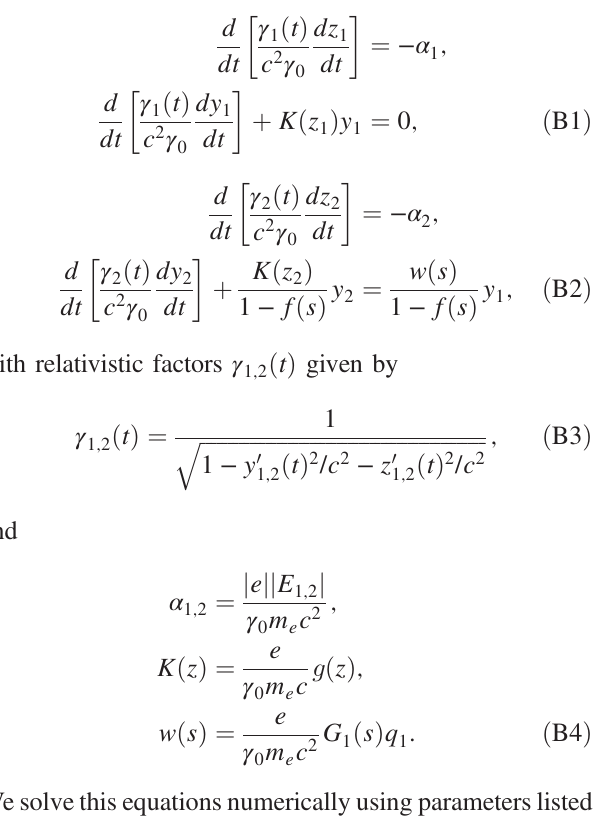
p ffiffiffiffiffiffiffiffiffiffiffiffiffiffiffi 1 − α . Simulation 1 z